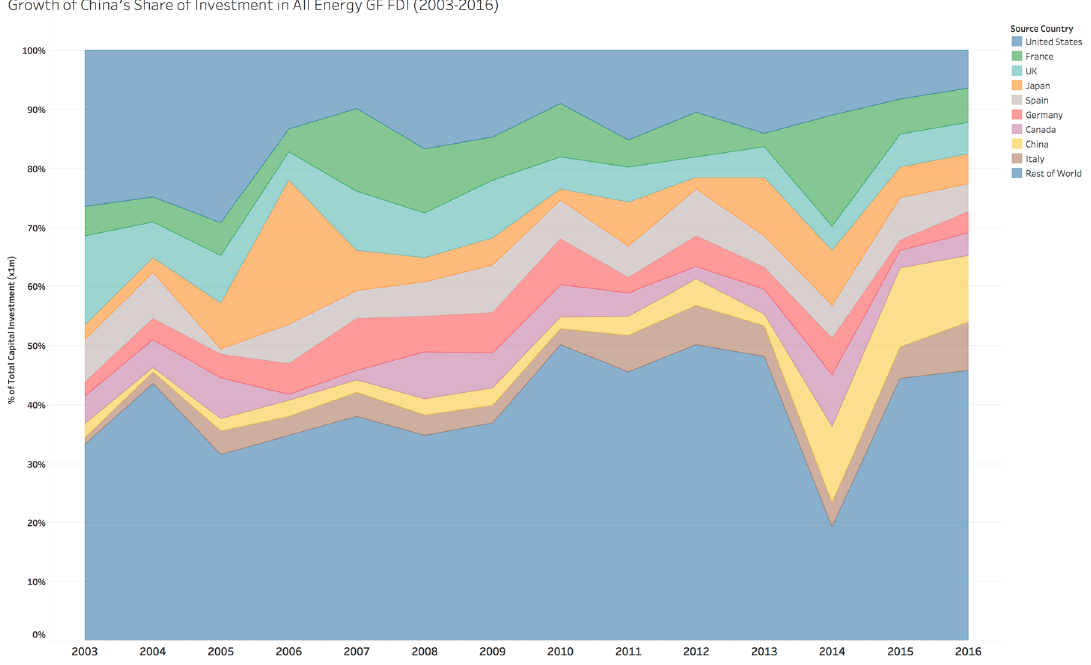
Figure 12. Growth of China’s share of investment in energy GF FDI.